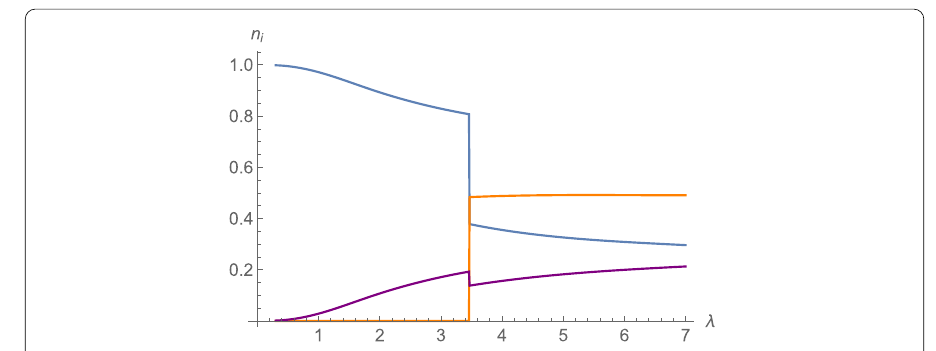
Figure 2 Relative occupation numbers of the ground state of the Bogoliubov Hamiltonian as functions of λ . The 1-mode is displayed in blue, the 2-mode in orange and the 3-mode in purple. There is a discontinuous change in the occupation numbers at λ gs ≈ 3.5